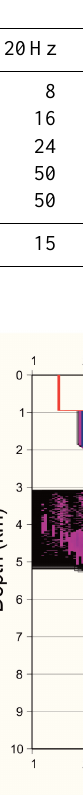
Table 4. Picking uncertainty in ms for every layer considered in metropolis algorithm.